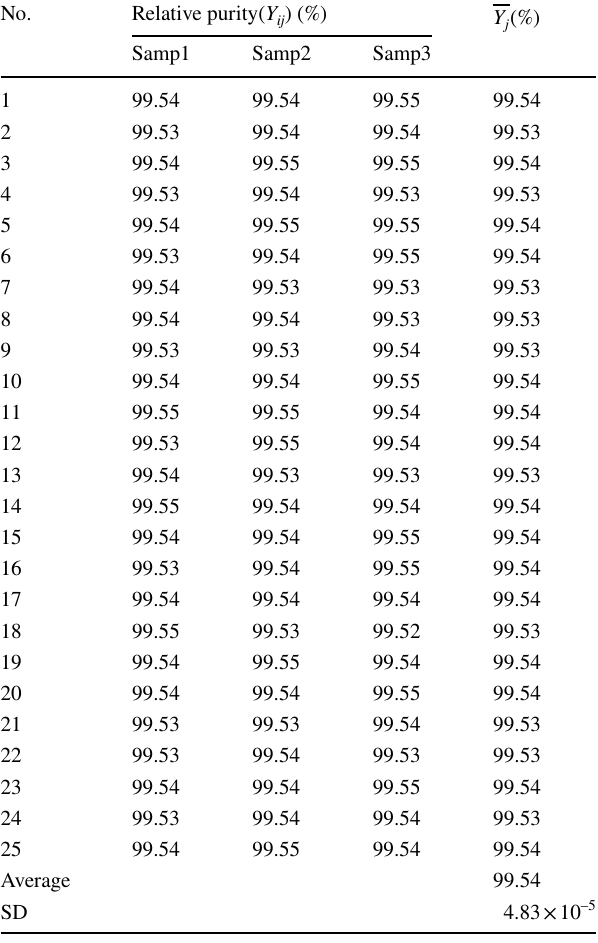
Table 2 Measurement data from the homogeneity test of Betulin